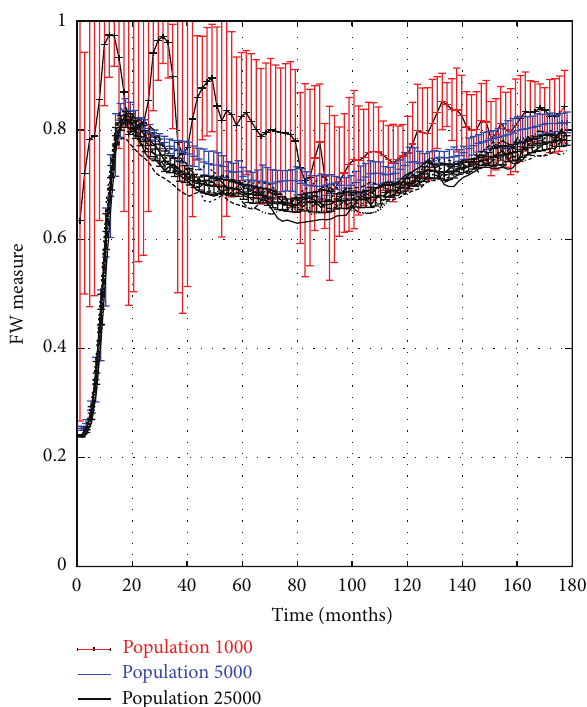
Figure 5: Firewall Hypothesis Validity in PWID networks of size 1k–25k